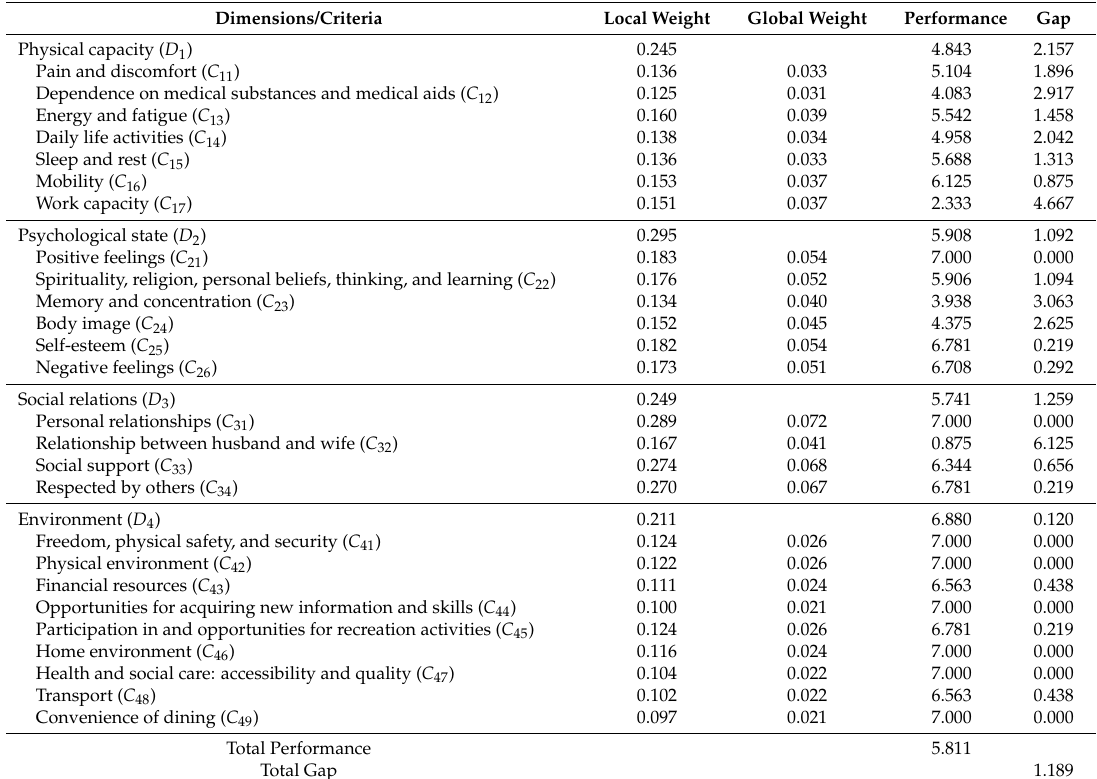
Table 6. The performance and gap evaluation of the case study using DANP-mV